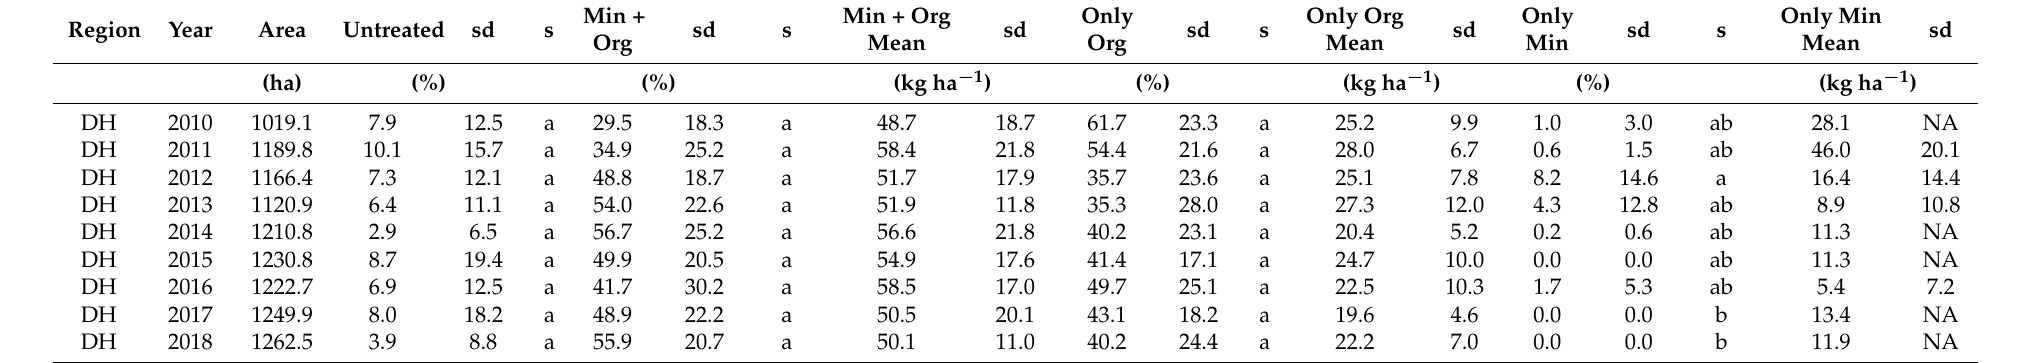
Table A2. Indicator frequency displayed in Figure 4 for untreated, mineral-only, organic (Org) and mineral (Min) and organic-only treatment ± standard deviation (sd). Different letters in a column represent significant differences between the years within a region (Kruskal–Wallis p < 0.05). Diepholz min+org and Diepholz only organic were distributed normally and tested with the Tukey test ( p < 0.05). Indicator amount used on the treated area ± standard deviation (kg ha − 1 ) is also displayed. DH: Diepholz, UE: Uelzen, RO: Rostock, FL: Fläming and OS: Oder-Spree. Area: total area (ha). Each farm contributes one value every year for frequency; for amount in some years some farms did not use P at all and, therefore, contributed no